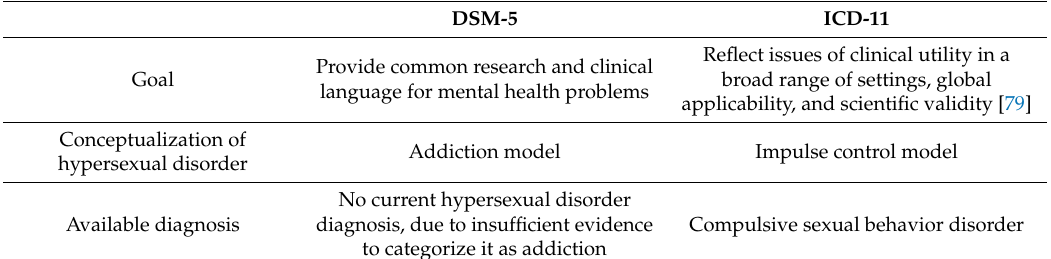
Table 1. DSM-5 and ICD-11 approaches to classifying hypersexual behavior.